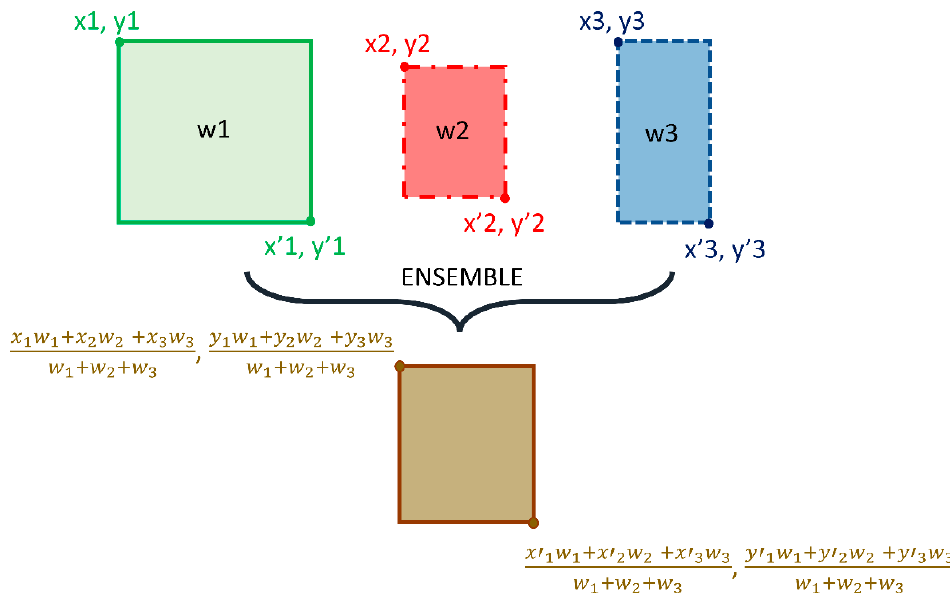
Figure 3. Method Schematic of the ensemble approach.